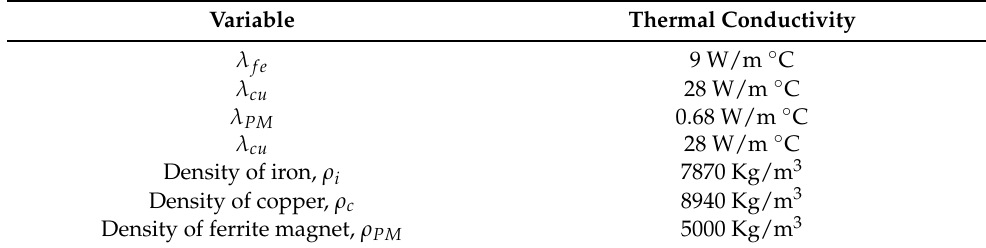
Table 7. Thermal conductivity of various parts.